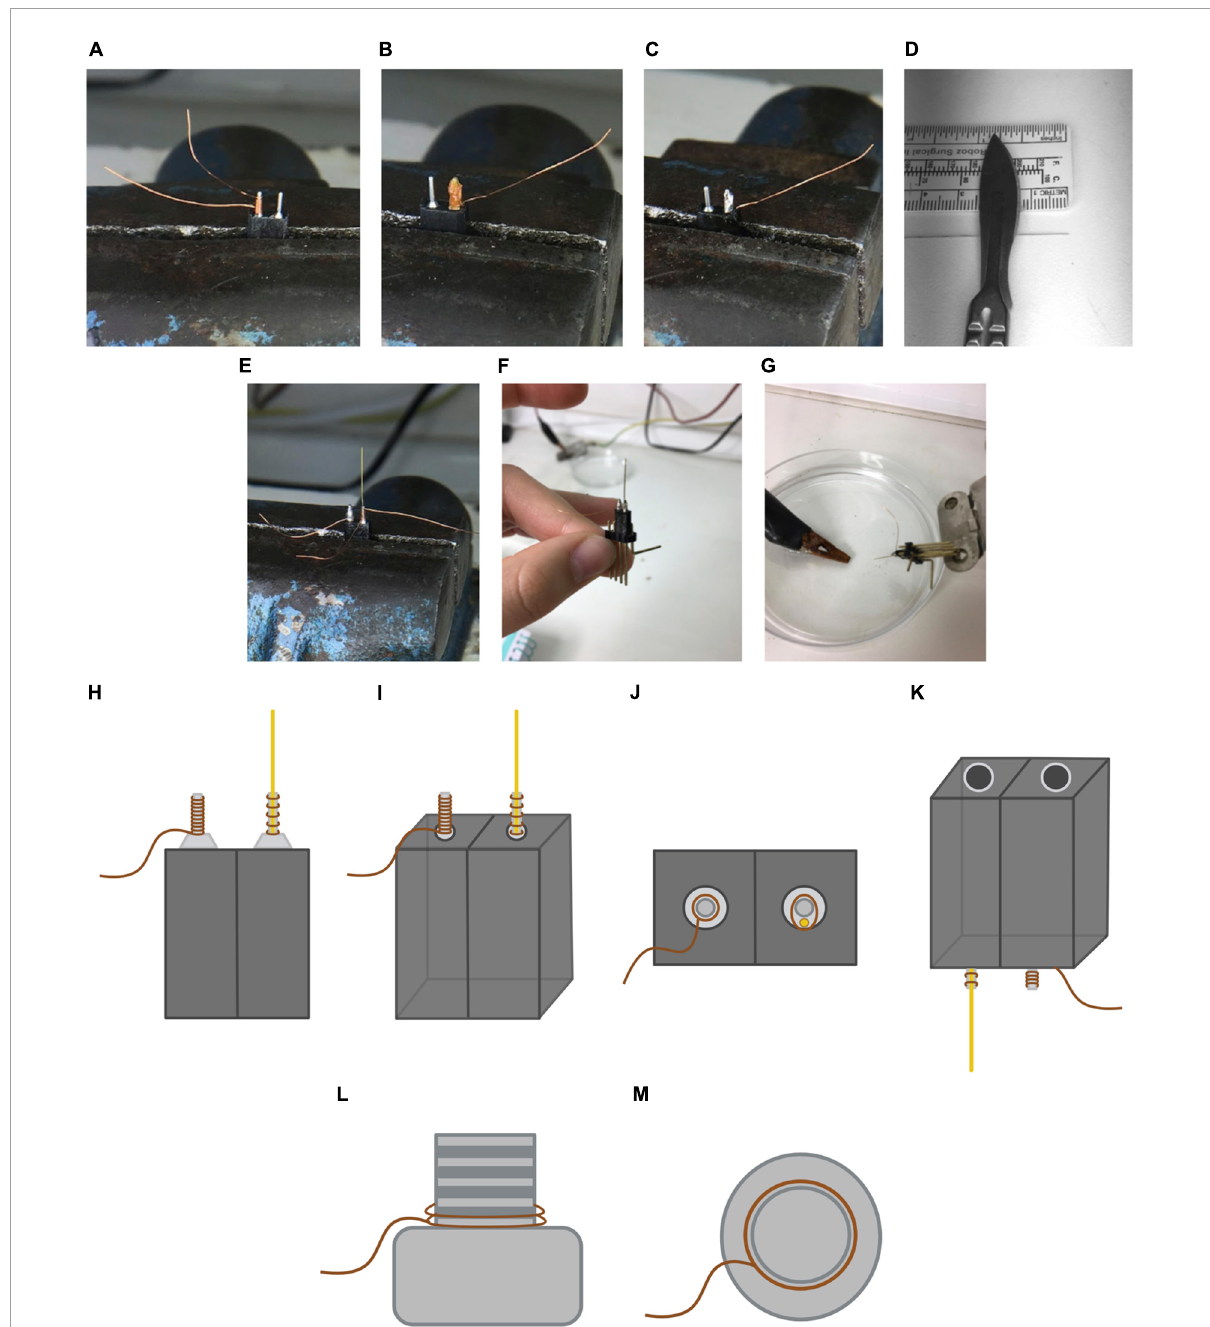
FIGURE6 Preparation and end result of the stimulation electrode. (A) Placement of the copper wire around the first horn, covering it until the top. (B) Placement of the solder flux paste around the wire to optimize the soldering process. Note that in this picture the excess wire in the bottom part is already cut. (C) End result of the first horn once it is soldered. (D) 1.3 mm electrode bit cut. (E) Placement of the electrode wire on the second horn. Note that once one of the extremes is stripped of insulating material, this end must face downward when placing it on the horn. (F) Placement of the resulting device in a male pin to check its connectivity. (G) Current verification of the electrode wire and copper wire with a power supply and a solution of water with dissolved NaCl. (H) Frontal view of the resulting stimulation electrode. The brown lines represent the copper wire while the gold line represents the electrode wire. Note that the soldering tin is not shown. Not to scale. (I) Frontal-lateral view of the stimulation electrode. (J) Top view of the stimulation electrode. (K) Bottom-lateral view of the stimulation electrode. (L) End result of the ground screw. Lateral view of the ground screw. The brown line represents the copper wire. (M) End result of the ground screw. Top view of the ground screw. Not to